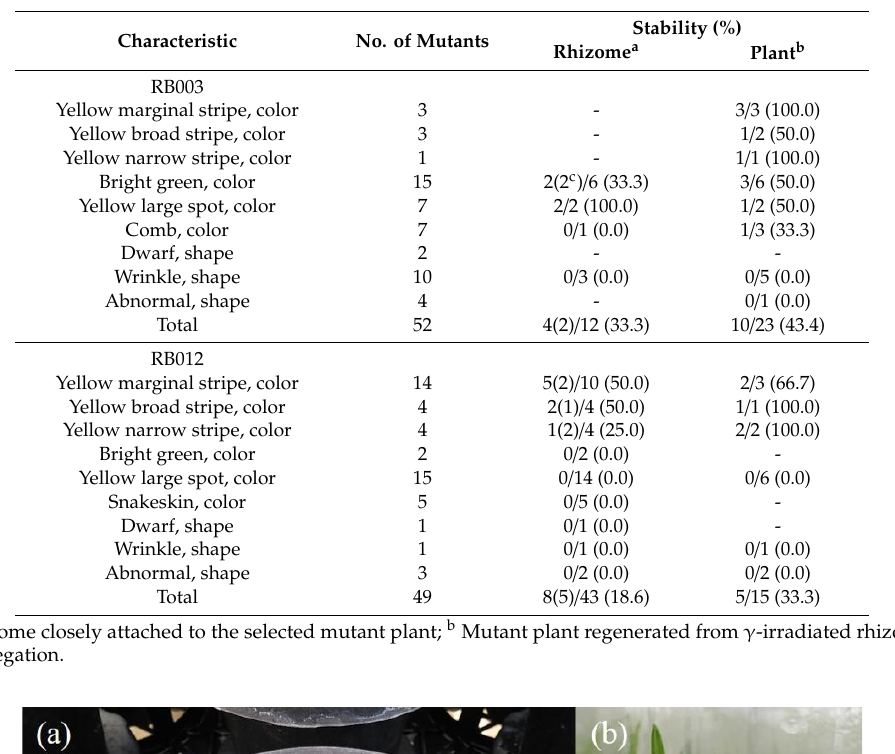
Table 2. Stability of leaf mutants induced by γ -irradiation in the Cymbidium hybrids, RB003 and RB012 populations.